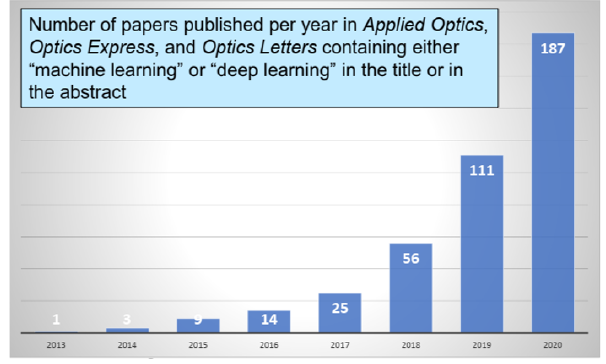
Fig. 1. Number of papers published per year in AI-Optics [9]